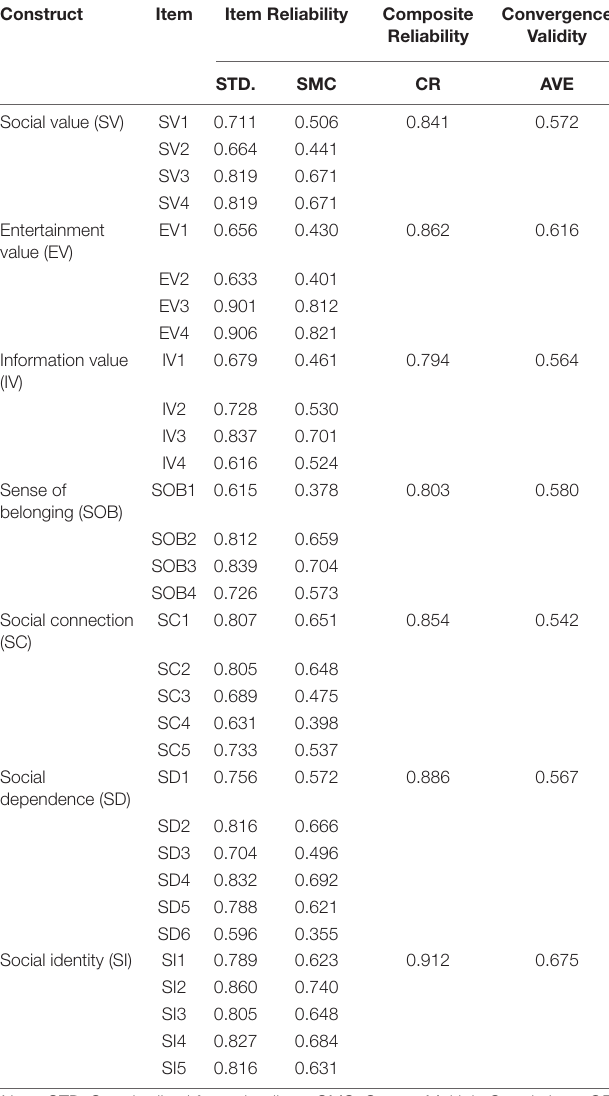
TABLE 1 | Confirmatory factor